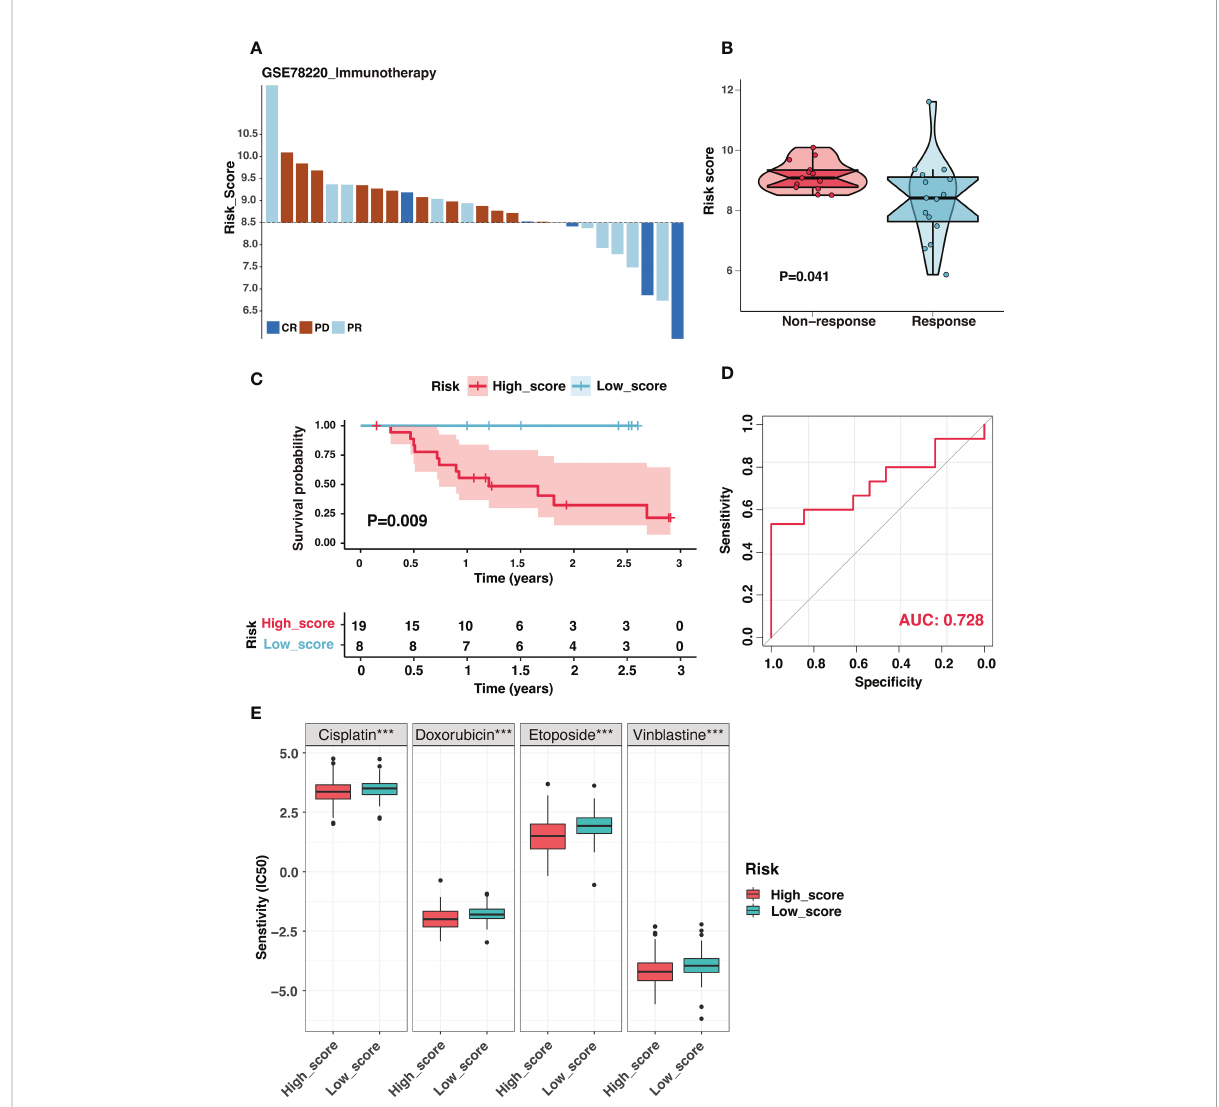
FIGURE 11 The ganglioside-related risk signature could predict immunotherapeutic response and chemotherapy sensitivity. (A) The distribution of immunotherapy responses at different risk scores in the GSE78220 cohort. (B) The comparison of risk scores between non-response and response groups in the GSE78220 cohort. (C) Kaplan – Meier curves of overall survival in GSE78220 cohort between different risk groups. (D) The receiver operating characteristic (ROC) curves for immunotherapy response prediction in the GSE78220 cohort. (E) The boxplot demonstrated different IC50 (the half maximal inhibitory concentration) values of four chemotherapeutic drugs, including cisplatin, doxorubicin, etoposide and vinblastine, between low-score and high-score groups. (***: P <